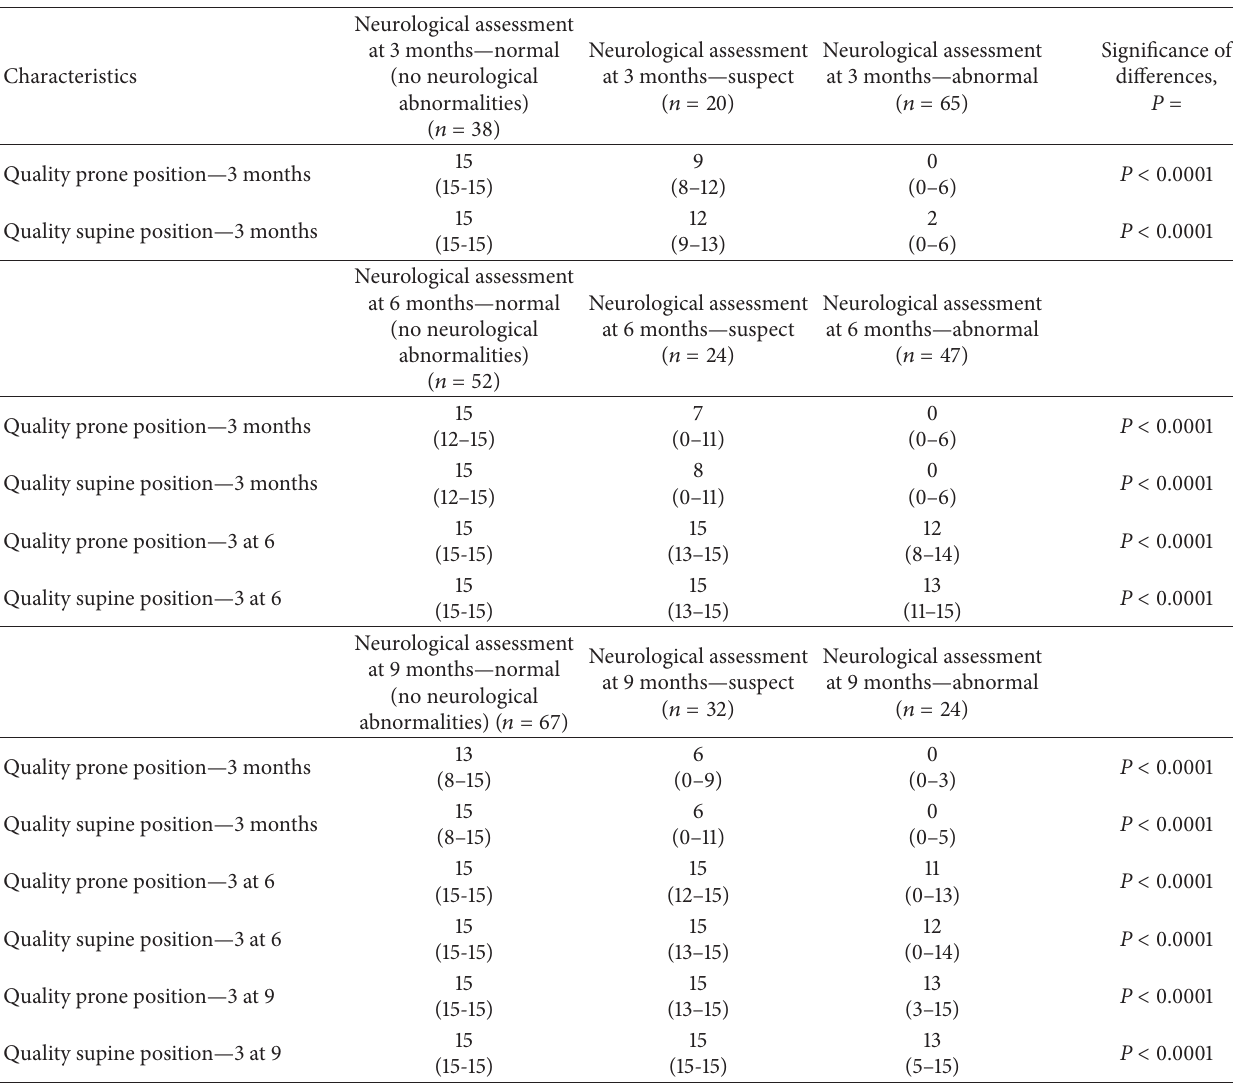
Table4:Qualitativeassessmentscores(maximumscoreof15)ininfantsat3,6,and9monthsinproneandsupineposition,reportedaccording to neurological assessment. Results are given as median (quartiles